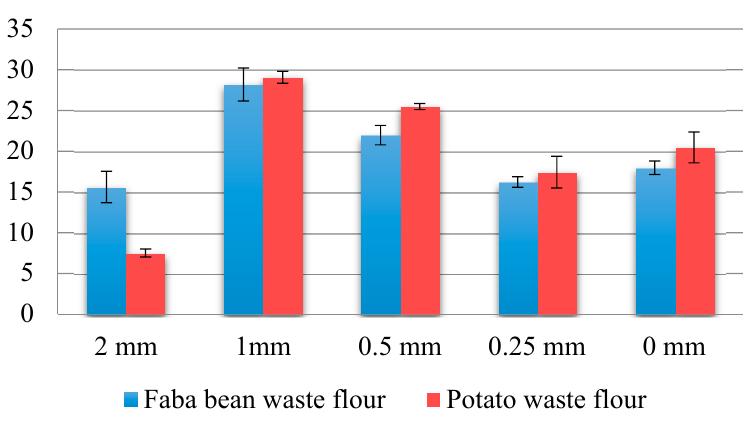
Figure 1. Fractional composition of faba bean and potato peel flour.